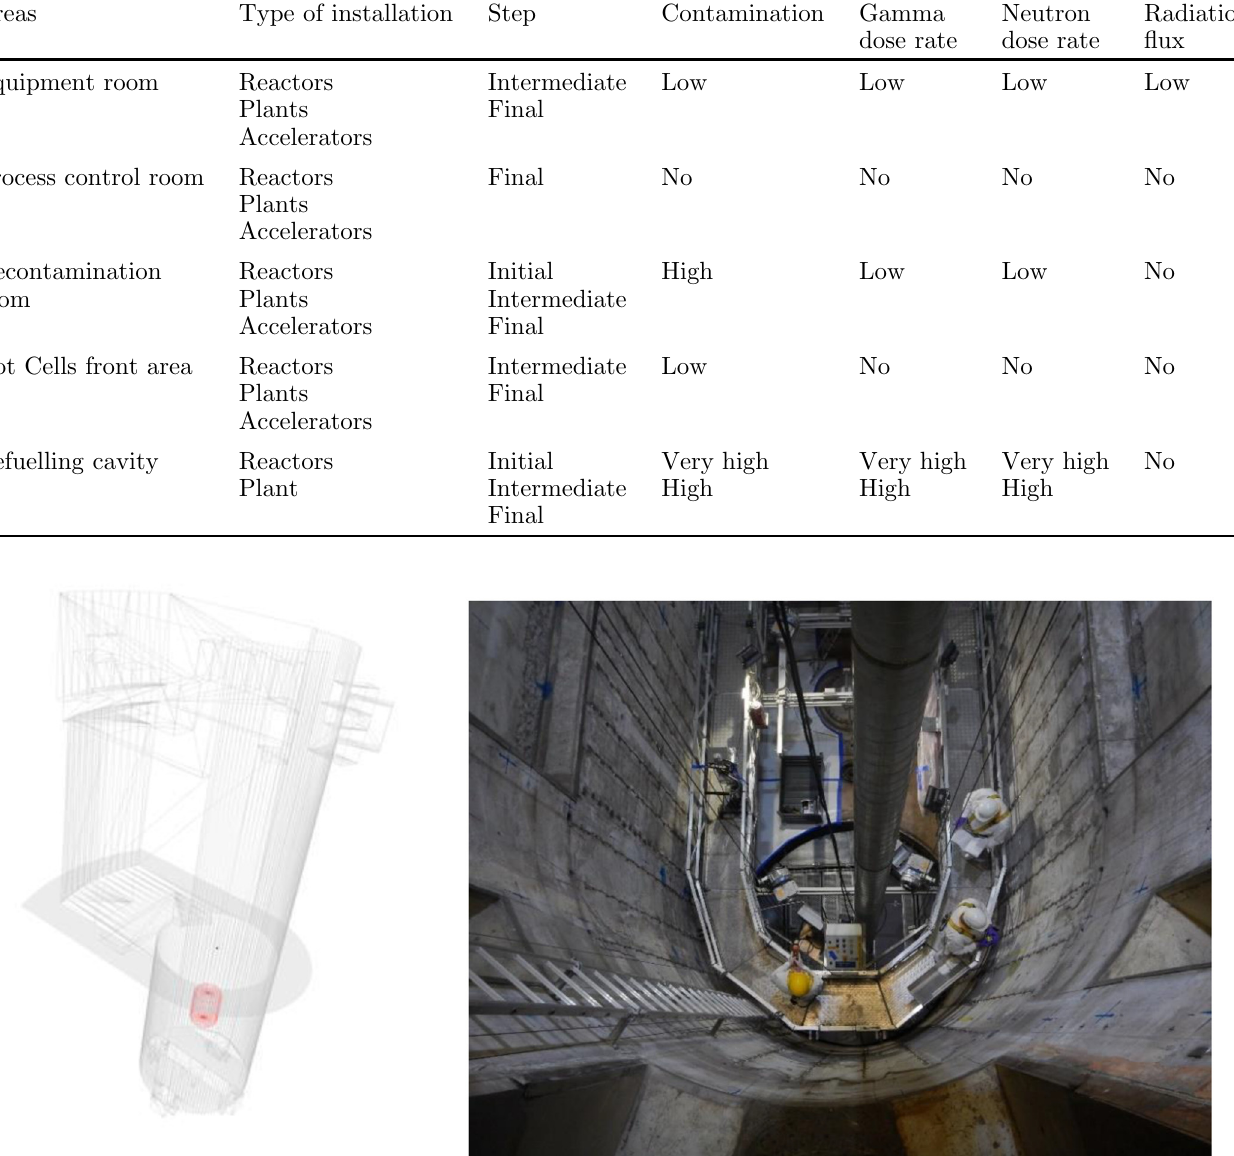
Table 1. Classi fi cation of areas according to the radioactivity constraint (an example).